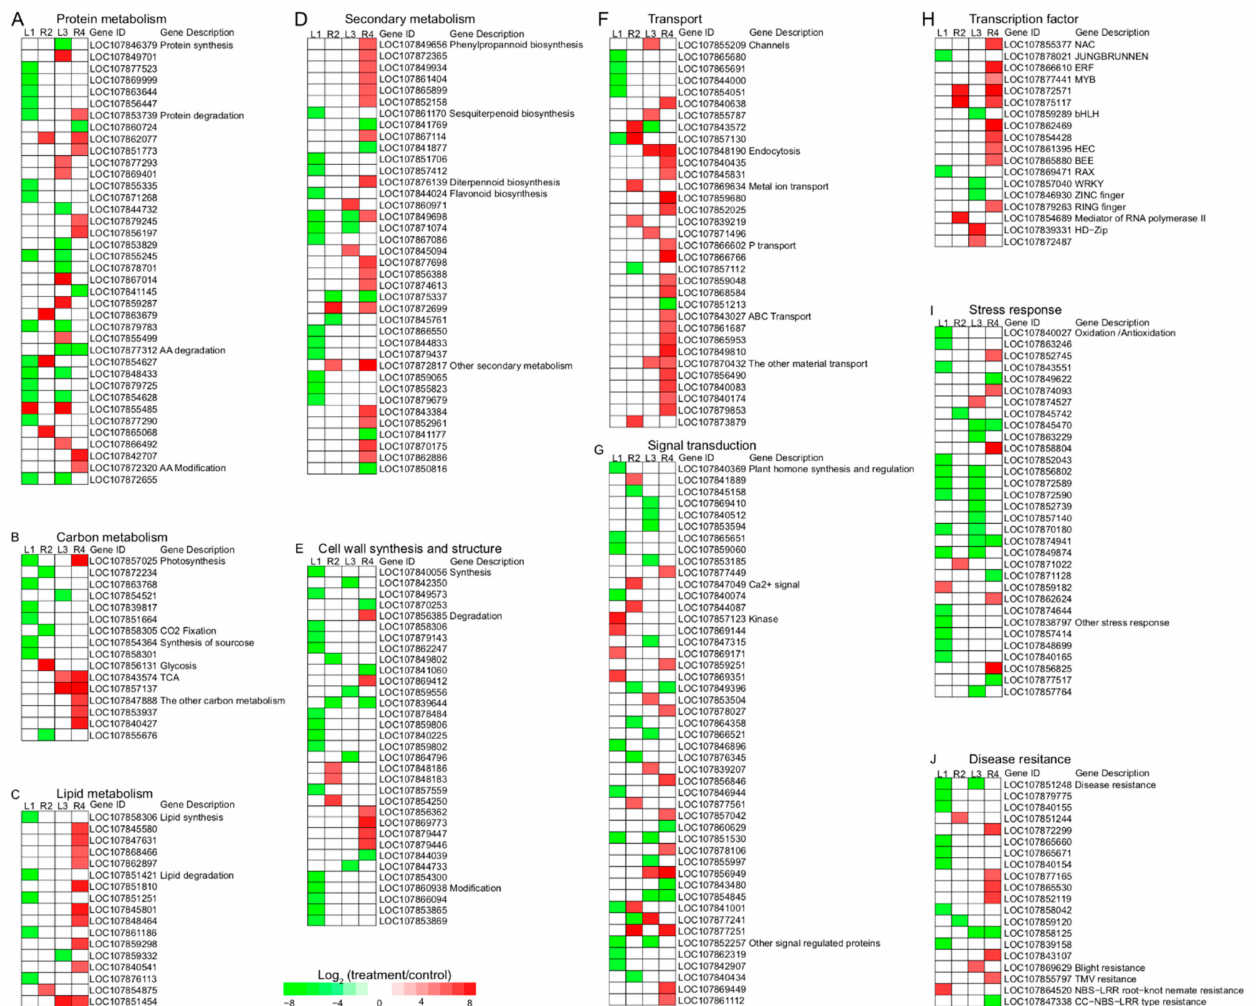
Figure 7. Classification of unique DEGs. ( A ): Protein metabolism. ( B ): Carbon metabolism. ( C ): Lipid metabolism. ( D ): Secondary metabolism. ( E ): Cell wall synthesis and structure. ( F ): Transport. ( G ): Signal transduction. ( H ): Transcription factor. ( I ): Stress response. ( J ): Disease resistance. L1, TCL1 vs. TTL3; R2, TCR2 vs. TTR4; L3, SCL5 vs. SCL7; R4, SCR6 vs.